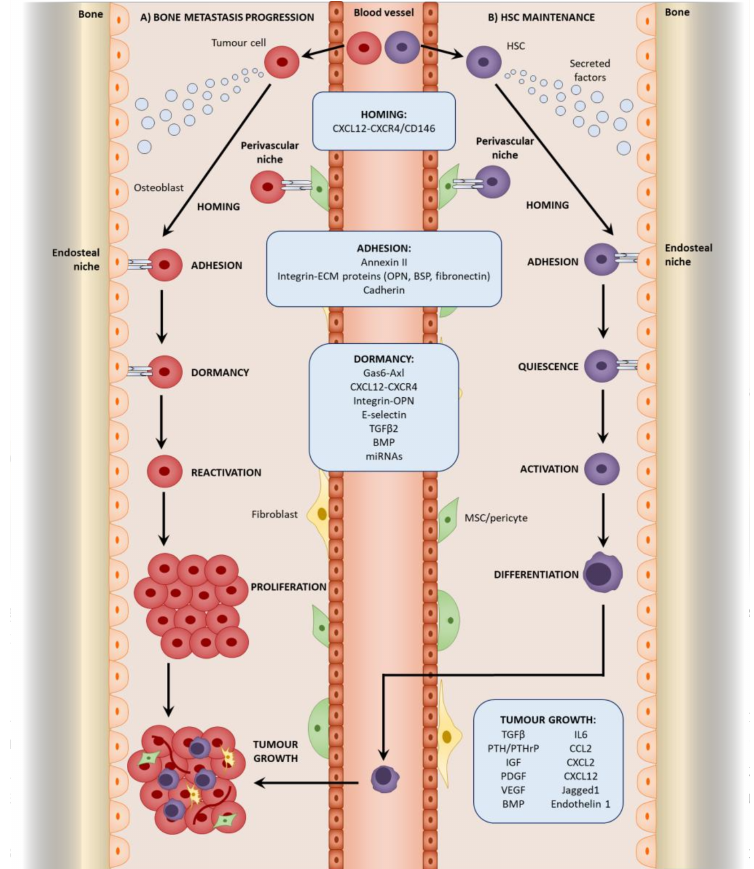
Figure 2. The involvement of the hematopoietic stem cell (HSC) niche in ( a ) bone metastasis progression and ( b ) HSC maintenance. Disseminated tumor cells (DTCs) and HSCs home to the endosteal and perivascular where they adhere to the osteoblasts and mesenchymal stem cells (MSCs), respectively, and remain dormant or quiescent. The tumor cells can then be activated and begin proliferating to form a bone metastatic lesion, whereas the HSCs differentiate to give rise to immune cells that enter the circulation (OPN osteopontin; BSP bone sialoprotein; TGF β transforming growth factor β ; PTH parathyroid hormone; PTHrP parathyroid hormone-related protein; IGF insulin growth factor; PDGF platelet derived growth factor; VEGF vascular endothelial growth factor; BMP bone morphogenetic protein; IL6 interleukin 6; CCL2 C-C motif chemokine 2; CXCL12 C-X-C motif chemokine 12)